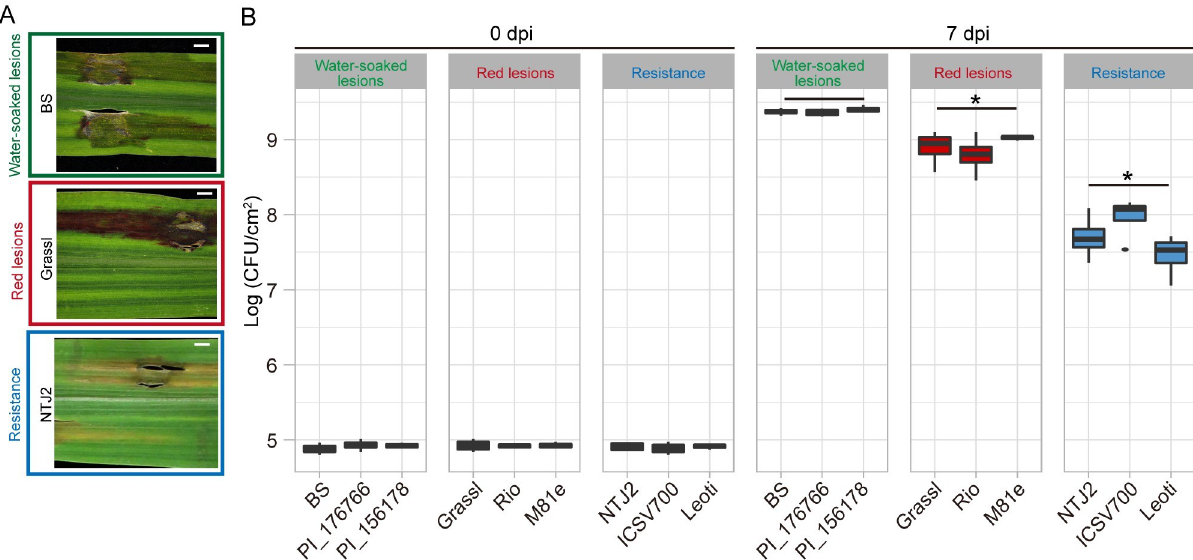
Fig 1. Xvh -disease phenotypes and bacterial growth in sorghum. (A) Xvh disease phenotypes: water-soaked lesions, red lesions, and resistance. (B) In planta bacterial growth assay. Sorghum leaves were infiltrated with Xvh (OD 600nm = 0.02 (~1 × 10 7 cfu/mL)). Bacterial populations were determined at 0 dpi and 7 dpi and are shown as colony-forming units (CFU). The mean ± s.d. was obtained from four biological replicates. Each replicate represents two inoculation areas from one leaf on one plant. Asterisks indicate statistical significance based on unequal variances t test (n = 12 (three genotypes × four replicates/genotype), � p < 0.05) comparison with the water-soaked lesions phenotype. dpi, days post-inoculation.